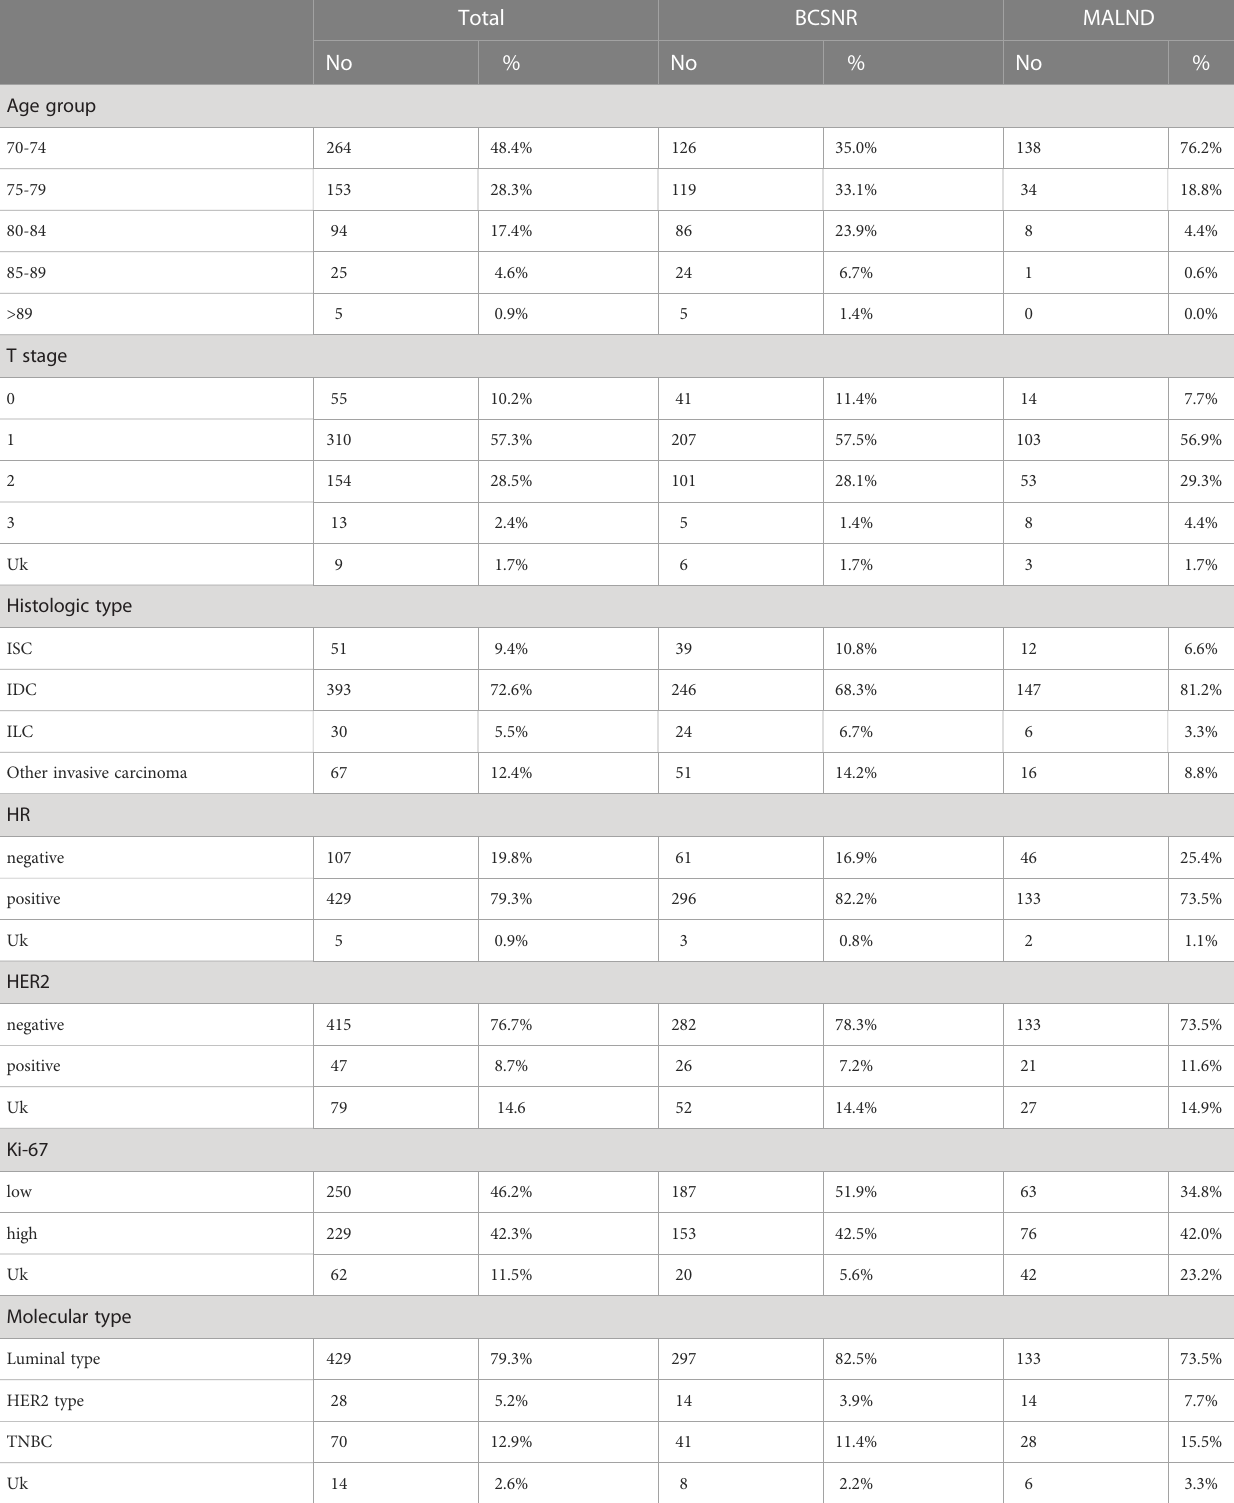
TABLE 1 Clinical characteristics according to operation